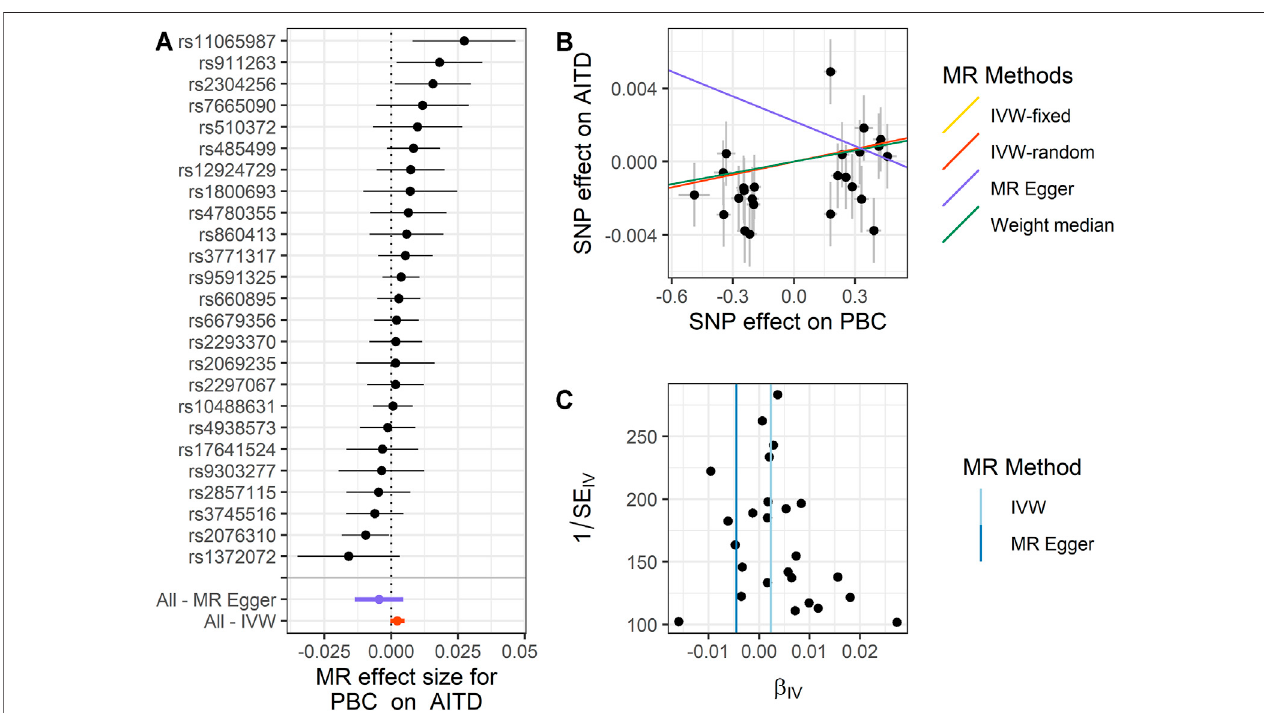
FIGURE2| SummaryoftheMRanalysisforPBConAITD. (A) MReffect sizeofeachIV,MR-Egger,andIVW. (B) ThescatterplotofcausaleffectsofPBConAITD. Weuseverticalandhorizontalblacklinestoshow95%CIoftheestimatedeffectofIVsonPBC(x-axis)andthatonAITD(y-axis),respectively.Weusetheredlinetoshow theIVWrandom-effectsmodel. (C) ThefunnelplotofthecausaleffectofPBConAITD.EachpointrepresentstheestimatedcausaleffectofeachIV.Theverticaldarkblue line represents the causal effect estimate obtained using the MR-Egger method; the light blue line represents the causal effect estimate obtained using the IVW method. MR, Mendelian randomization; PBC, primary biliary cholangitis; AITD, autoimmune thyroid disease; IV, instrumental variable; IVW, inverse variance weighting.